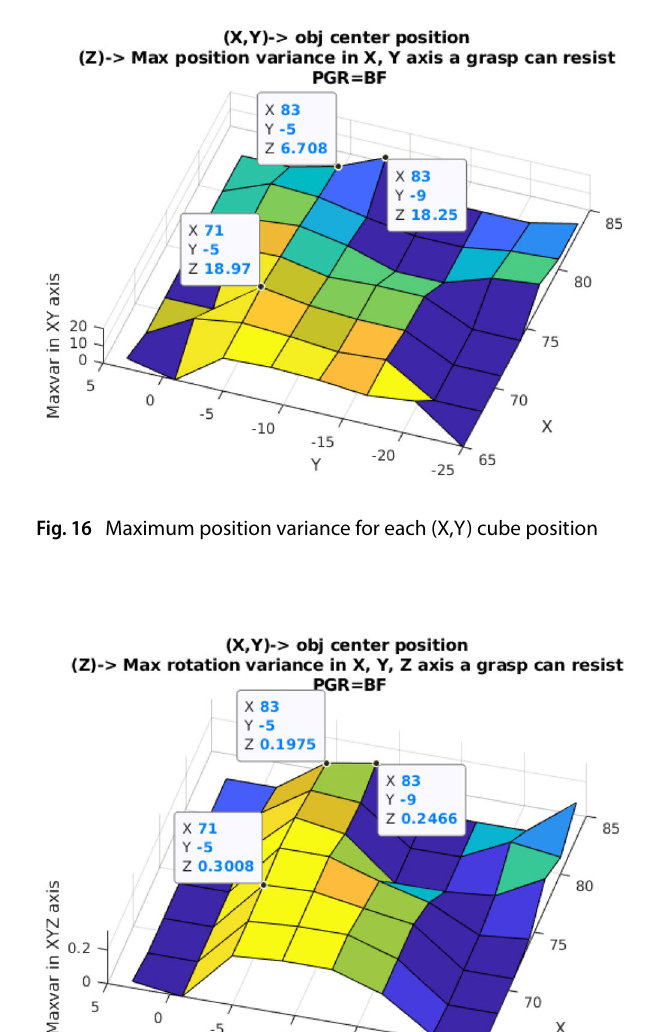
Fig. 14 PGR PoseVar index for each (X,Y) position of the cube